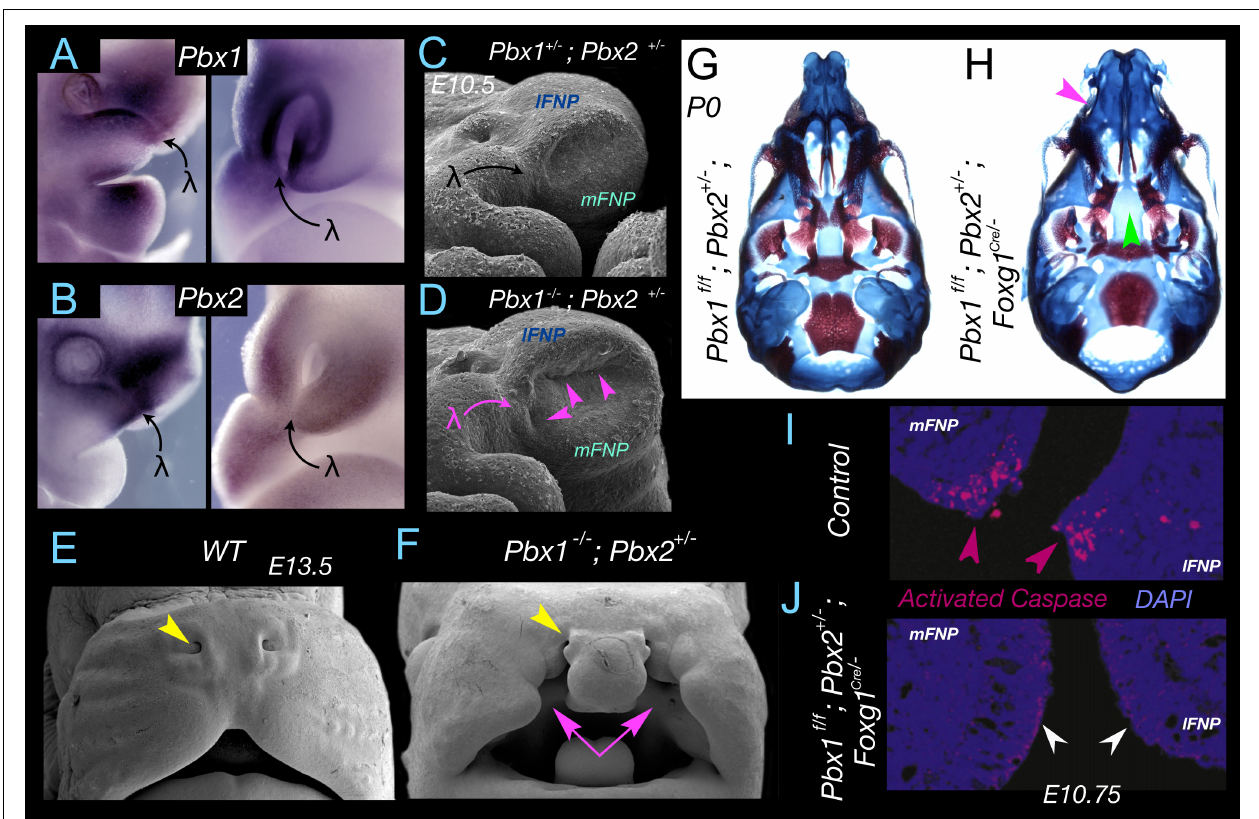
FIGURE 4 | Pbx , apoptosis, and apical-apical epithelial apposition at λ . (A,B) Pbx1 (A) and Pbx2 (B) expression at λ in E10.75-E11 mouse embryos. Expression is found in both the epithelium and the CNC. (C,D) Significant alteration of λ and the topography of the mFNP, lFNP and mxBA1 appositions (magenta arrowheads)